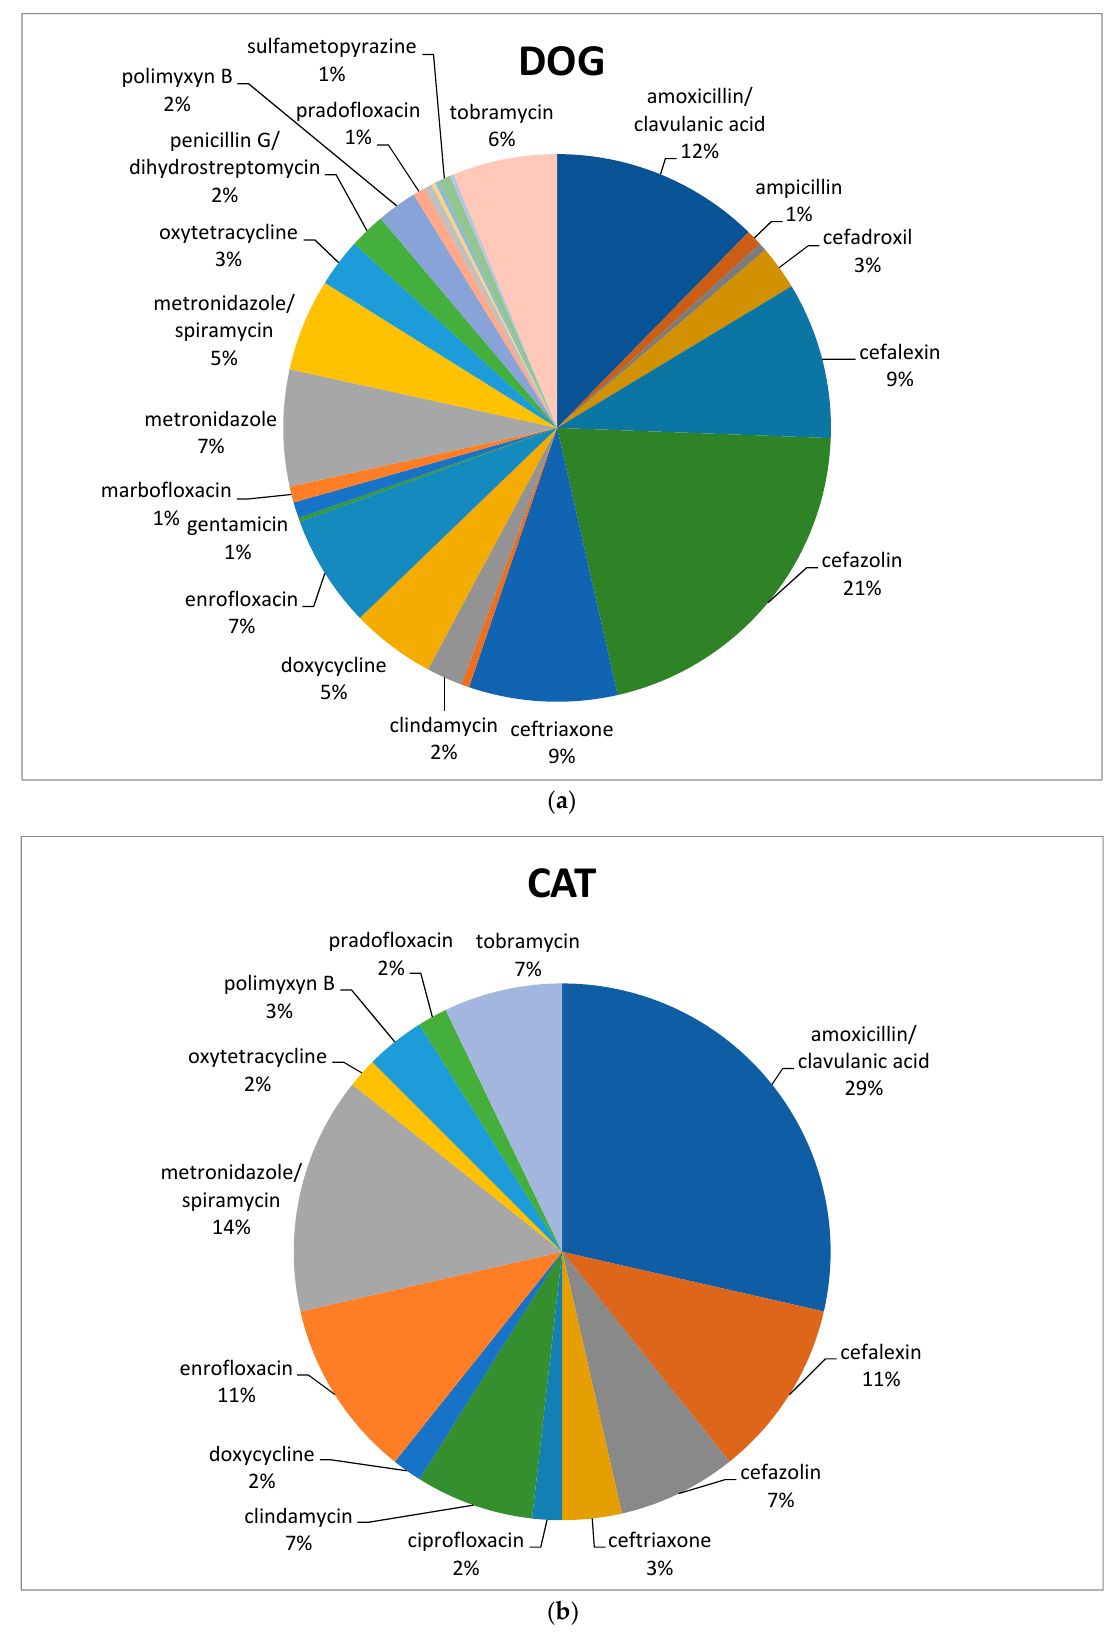
Figure 1. Percentage of selected antimicrobials prescribed in dogs ( a ) and cats ( b ) before the mandatory use of VEP.